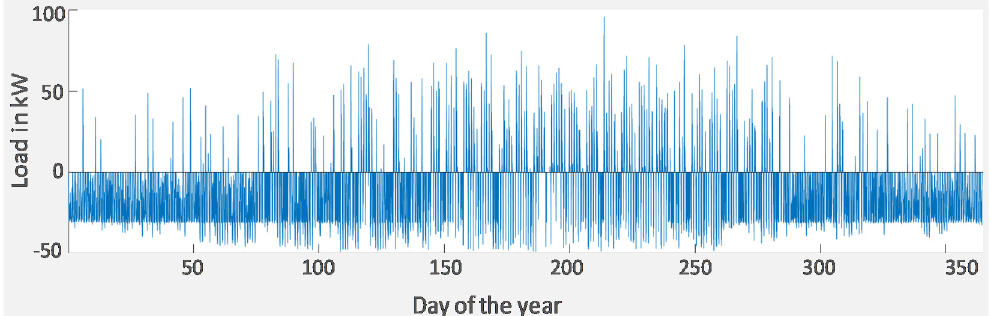
Figure 4. Grid load simulation results for scenario S4 with a self-consumption maximising strategy over the year. Feed-in to the gird is negative on the y-axis, purchase positive.